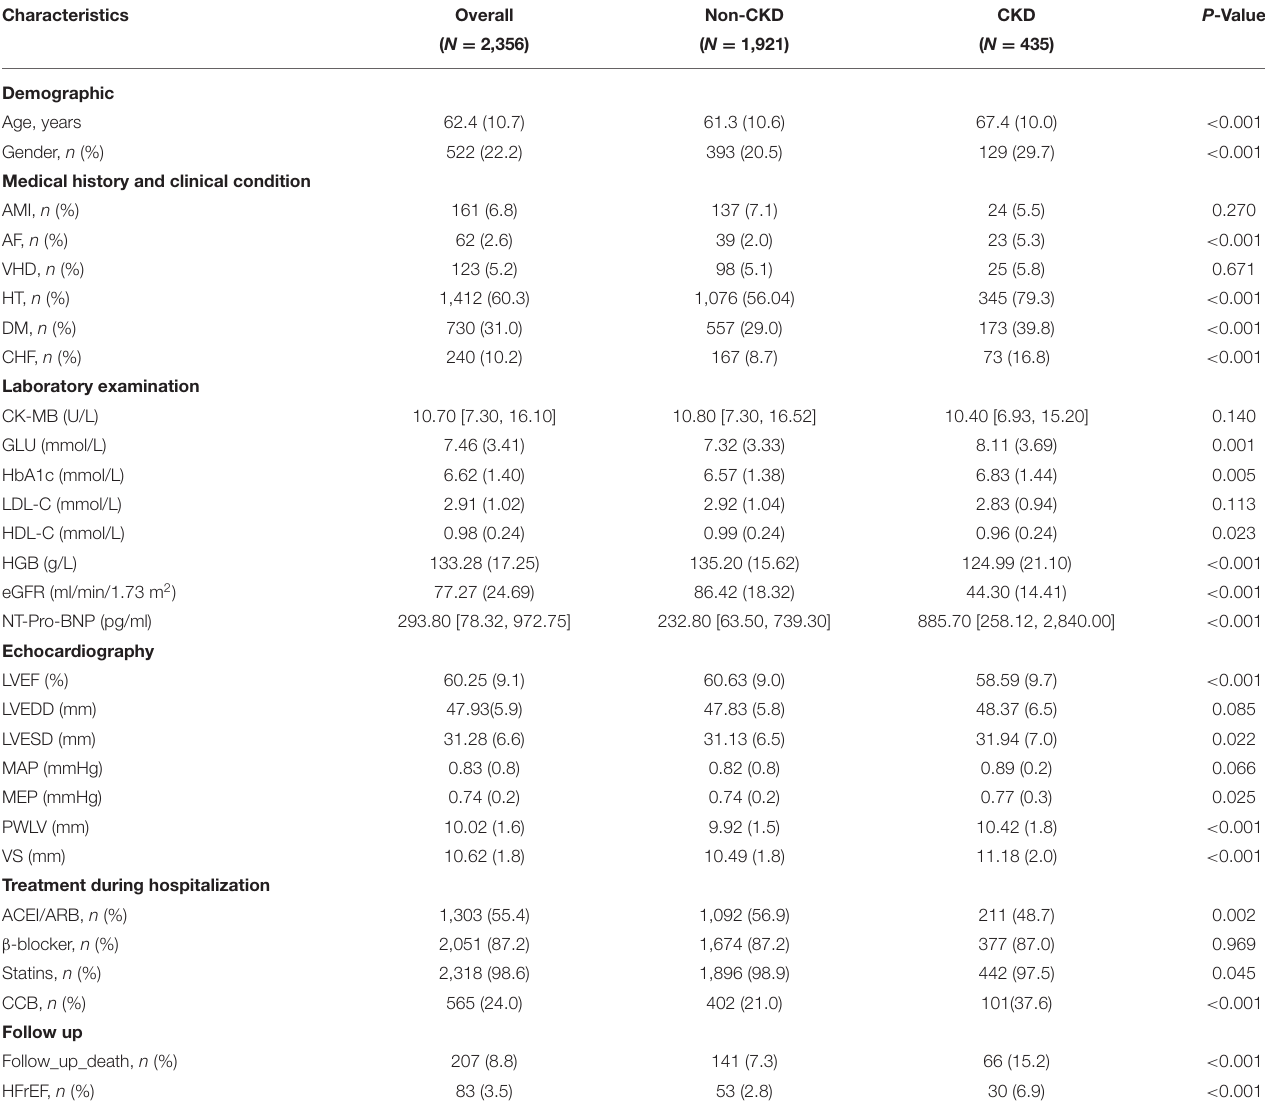
TABLE 1 | Baseline characteristics of patients with and without CKD undergoing PCI.